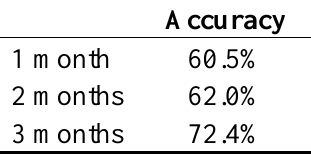
Table 6. Overall 6 condition classification accuracy for 1, 2, and 3 month old age groups.